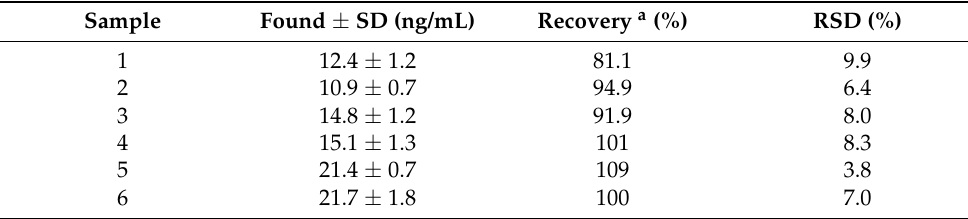
Table 4. Analytical results of MID in urine samples from the patients administered